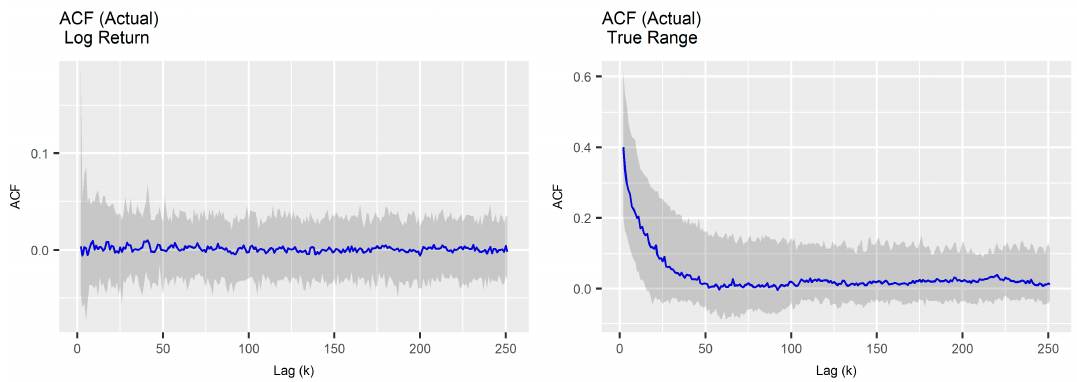
Figure 1. First stylized fact.